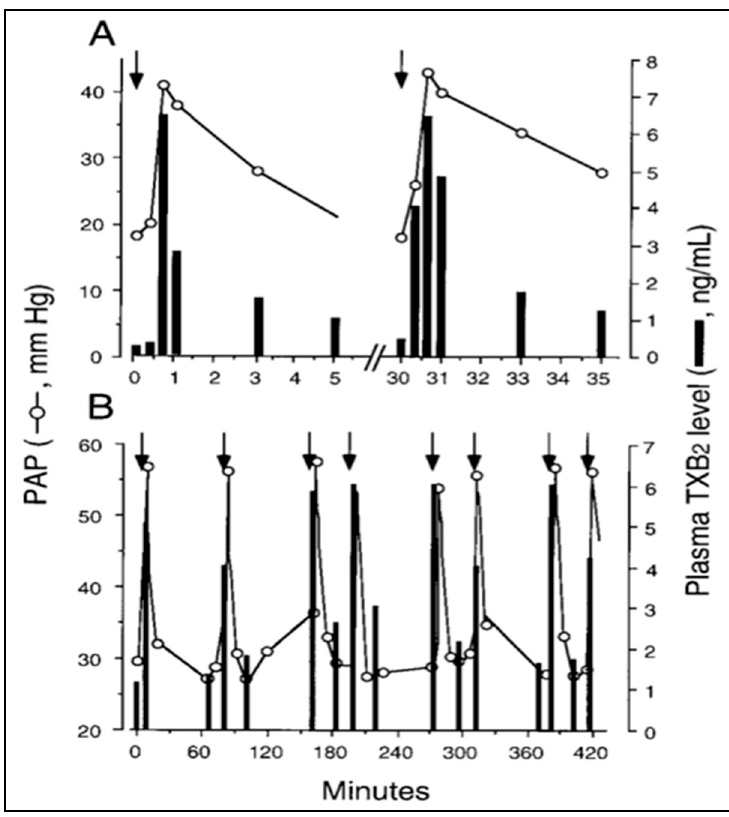
Figure 1. Time course of liposome-induced changes in plasma TXB2 and PAP in pigs. Two animals were repetitively injected with liposome boluses, and changes in PAP (circles) and plasma TXB2 (bars) were plotted as a function of time for the first two injections in one pig ( A ) or over 7 h in another pig ( B ). Other details are in Ref. [15], from where this figure was reproduced with permission. Arrows here indicate the timing of liposome injection.